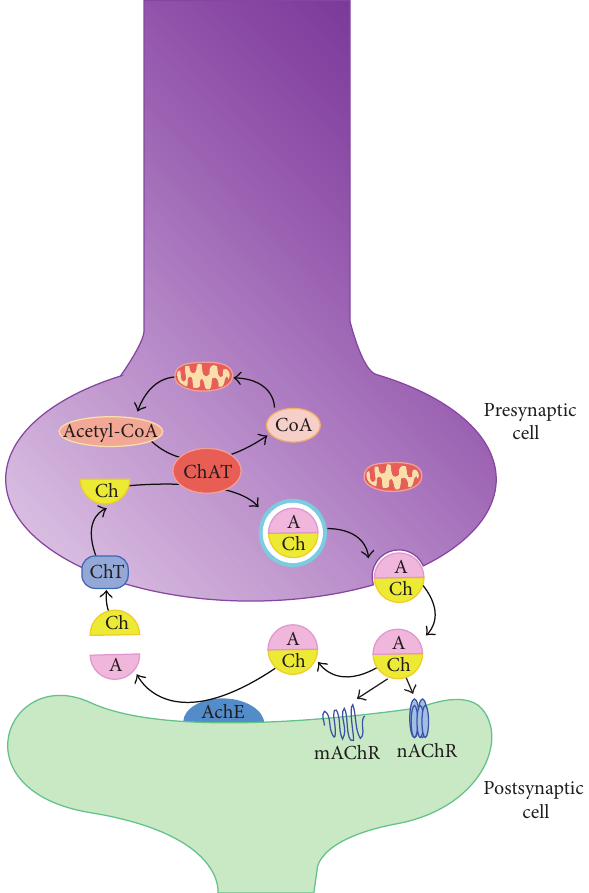
Figure 2: Synthesis of acetylcholine in synapse. A: Acetyl; AChE: acetylcholinesterase; Ch: choline; ChAT: acetylcholine transferase; ChT: choline transporter; CoA: coenzyme A; mAChR: muscarinic receptor; nAChR: nicotinic receptor.